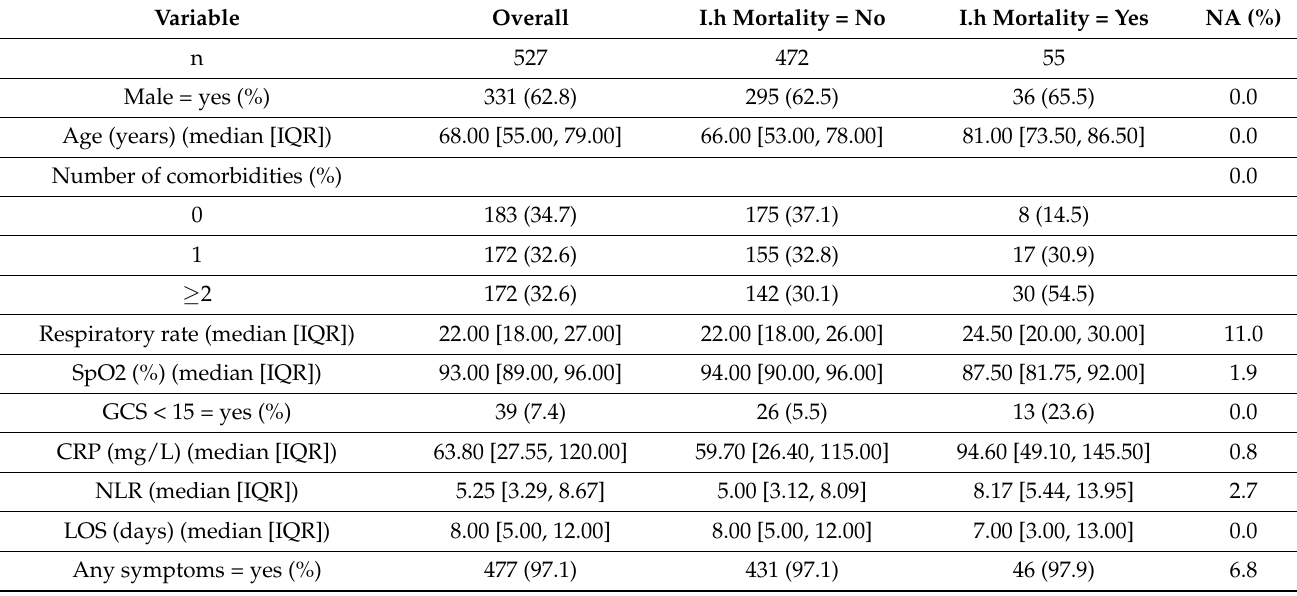
Table 4. Clinical and demographic characteristics of modified 4C Mortality Score validation